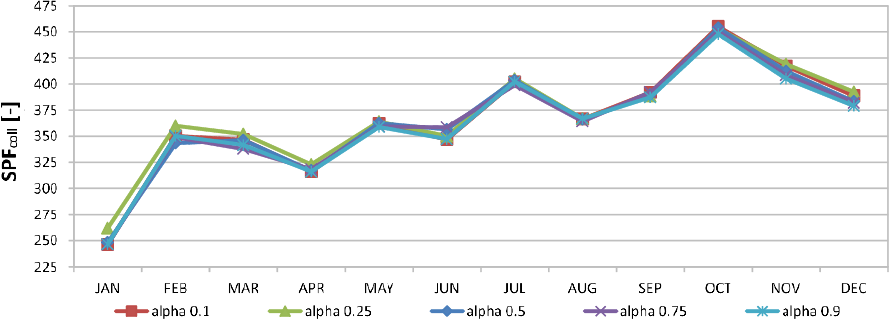
Figure 11. Monthly profile of SPF coll with Q-learning and different learning factors ( 𝛼 = 0.1,0.25,0.5,0.75,0.9 ).